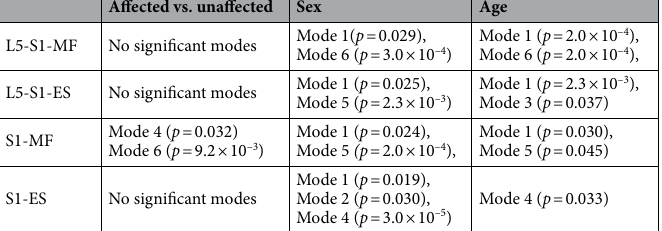
Affected vs. unaffected